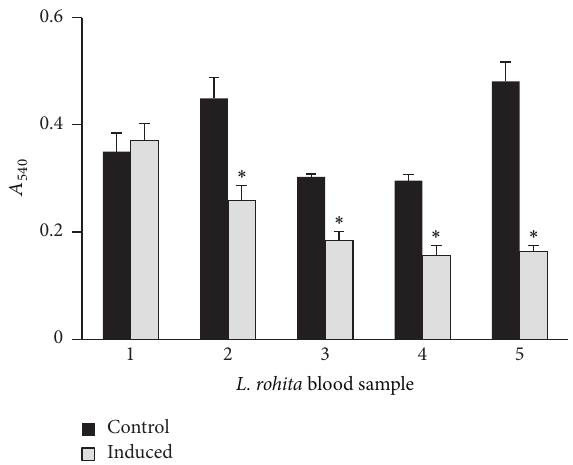
Figure 4: Effect of r Lr IL-10 on phagocytic activity of peripheral bloodcell.Peripheralbloodcells(intriplicate)from5differentfishes were treated with PBS (control) or r Lr IL-10 (10 𝜇 g/mL). Phagocytic activity was measured by NBT uptake and formazan crystals formation. Data represent mean ± SD. “ ∗ ” denotes statistically significant difference ( 𝑝 ≤ 0.05 ) in phagocytic activity of blood cells from the individual fish treated with r Lr IL-10 in comparison to